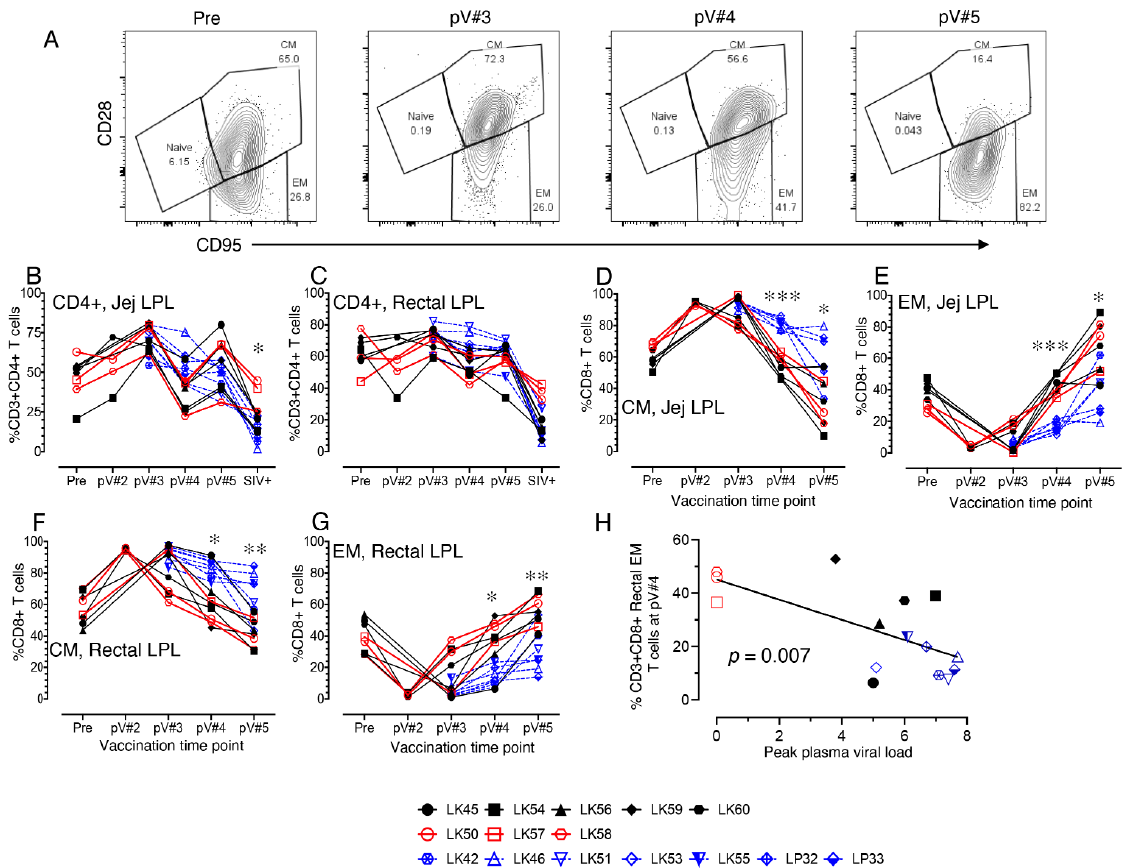
Figure 5. Dynamics of naïve and memory T cell populations during vaccination and post SIV infection in vaccinated and control macaques in mucosal tissues. ( A ) Representative contour plots showing the increased population of effector memory (EM) rectal lamina propria lymphocytes (LPL) CD8+ T cells in a macaque LK50 over the course of vaccination. Frequency of jejunum ( B ) and rectal ( C ) CD4+ T cells are shown for both vaccine and control macaques. A rapid loss of mucosal CD4+ T cells is detected in all infected macaques one month post confirmed infection. There was no loss of mucosal CD4+ T cells detected in vaccine protected (VP) macaques. Dynamics of central memory (CM; D , F ) and EM ( E , G ) CD8 T cell population in jejunum and rectal LPL are shown for vaccine ( n = 8) and control ( n = 7) macaques over the vaccination time points. Interestingly, all vaccinated ma- caques had a significantly higher effector memory CD8 T cell detected from 2 weeks post vaccina- tion 4 (pV#4) onwards. ( H ) Pearson’s correlation analys is demonstrated a significant negative cor- relation between rectal EM CD8+ T cell frequencies at pV#4 and peak plasma VL between vaccine and control macaques ( p = 0.007, r = -0.6637). Black and red lines represent vaccinated infected (VI) and VP macaques, respectively. Blue dashed lines represent control macaques. Asterisks denote sta- tistically significant differences between vaccine and control groups for the specific time point (* p < 0.05, ** p < 0.01, and *** p < 0.001). 3.8. CD38+ T cell Activation in Vaccinated Macaques T cell activation was also indirectly assessed by CD38 surface expression. A signifi- cant increase in CD38 expression in vaccinated macaques was evident at post V#4 time points in both jejunum and rectal CD4 and CD8+ T cells compared to controls ( p <0.001, Figure 6A – D). Pearson ’s correlation coefficient analysis between jejunum CD8+CD38+ T cells and the peak plasma VL from control and vaccine macaques indicated a significant